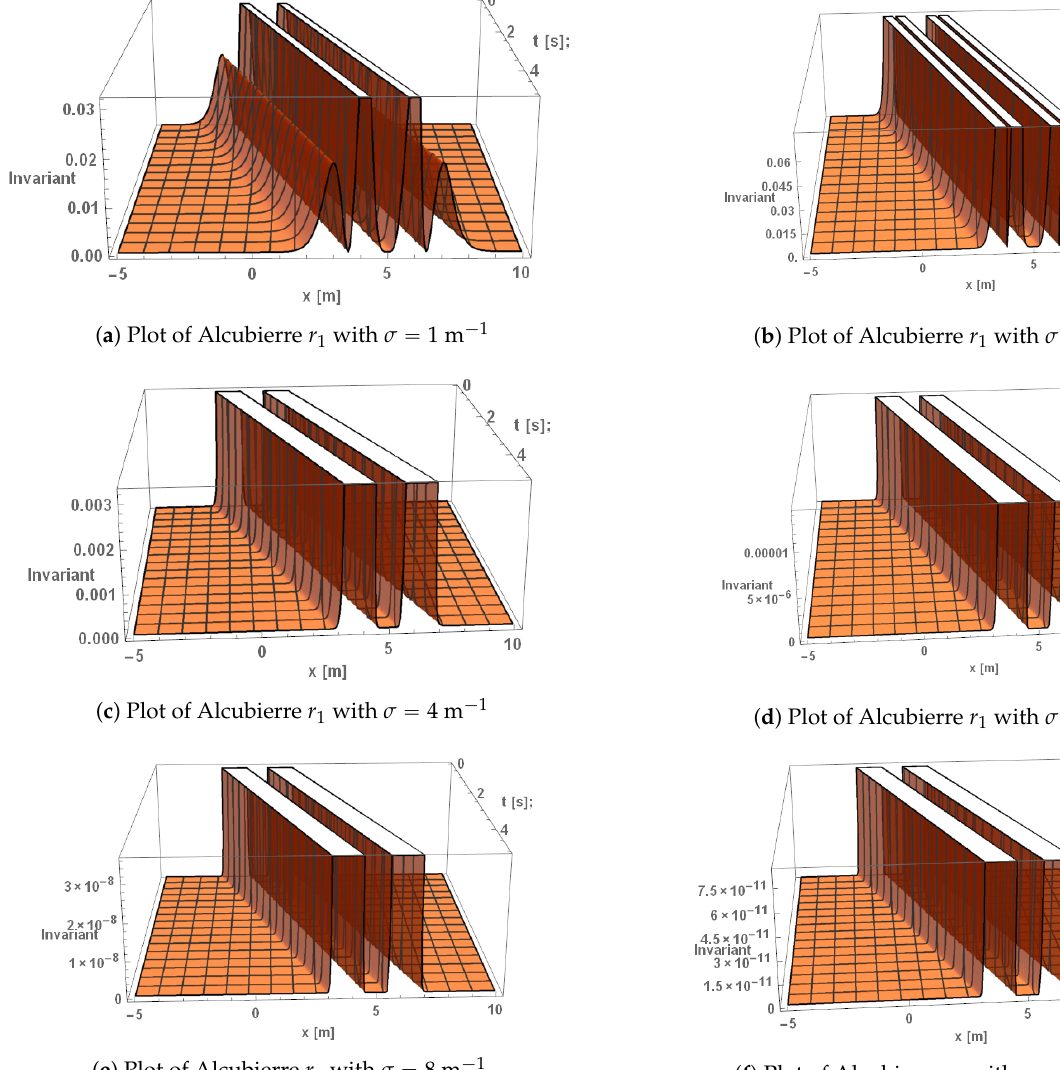
Figure A3. Plots of the r 1 invariants for the Alcubierre warp drive while varying skin depth. The other parameters were chosen as v s “ 1 c and ρ “ 1 m to match the parameters Alcubierre originally suggested in his paper